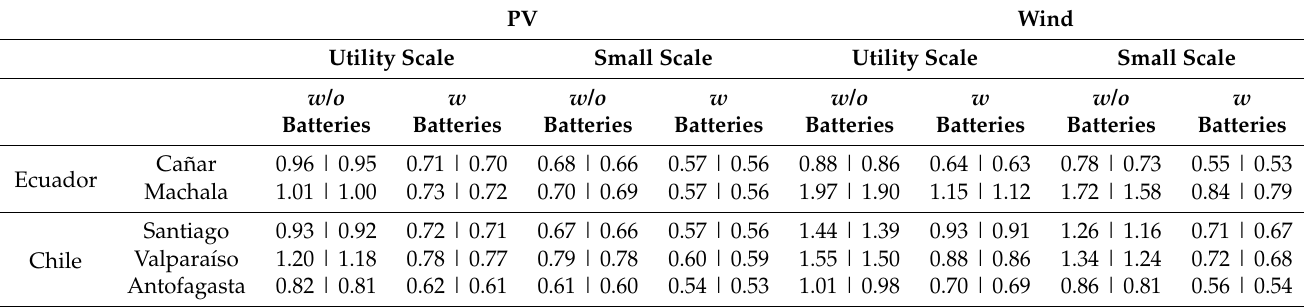
Table 5. LCOW ( € /m 3 ) analysis (left/right values correspond to SEC = 1.0 and 0.5 kWh/m 3 , respectively). PV Wind Utility Scale Small Scale Utility Scale Small Scale w / o w w / o w w / o w w / o w Batteries Batteries Batteries Batteries Batteries Batteries Batteries Batteries